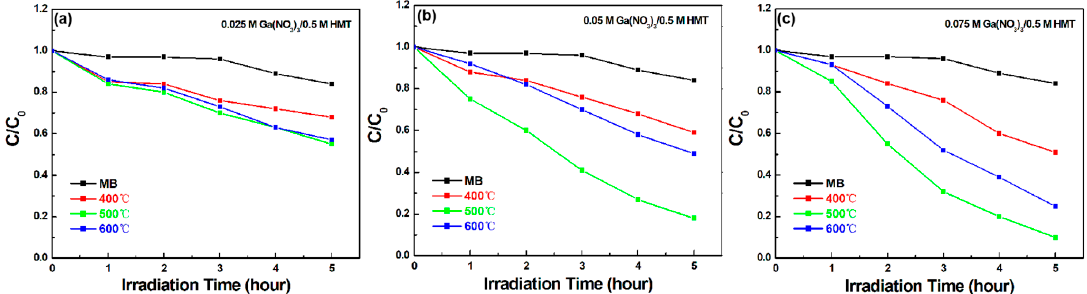
Figure 7. Calculated constant reaction rate of MB photodegradation (C/C 0 ) by Ga 2 O 3 plotted as a function of UV irradiation time. The Ga 2 O 3 samples were obtained following annealing of GaOOH prepared at Ga(NO 3 ) 3 concentrations of ( a ) 0.025 M, ( b ) 0.05 M and ( c ) 0.075 M.